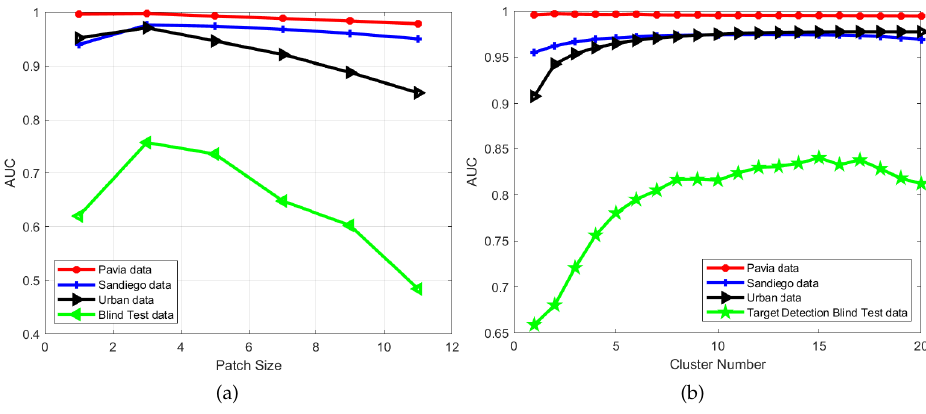
Figure 25. Parameter analysis for the patch size and cluster number for the proposed algorithm with the four real-world hyperspectral datasets. ( a ) AUC versus the patch size for the proposed algorithm; ( b ) AUC versus the cluster number for the proposed